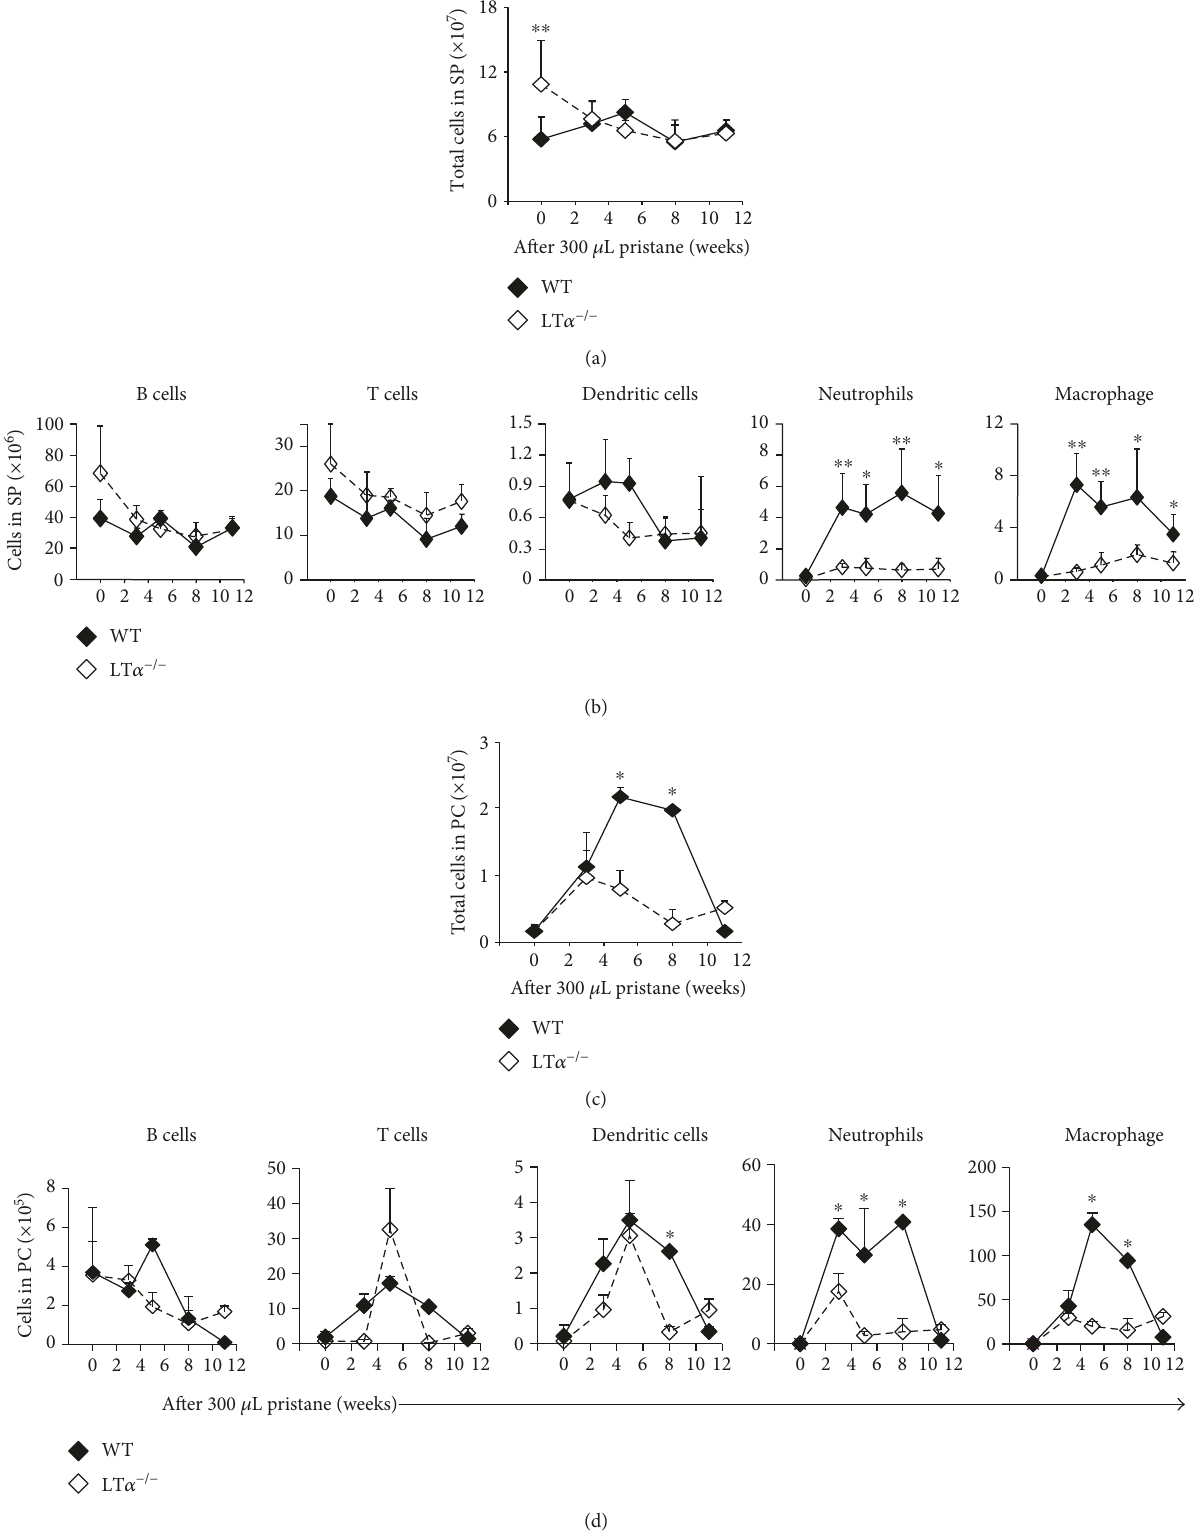
Figure 3: LT α lossinhibited the recruitment ofboth splenic neutrophils and macrophages in response to pristane treatment. (a, b) LT α − / − mice and WT mice were injected with 300 μ L (8.3 × 10 − 4 mol) of pristane and were then sacri fi ced at the indicated time points. The total number of cells and the number of each cell type were calculated. (c, d) The total number of cells or the number of each cell type in the PC was also analyzed. The di ff erence between WT and LT α − / − mice is shown. Data represent two independent experiments. ∗ p < 0 05 and ∗∗ p < 0 01